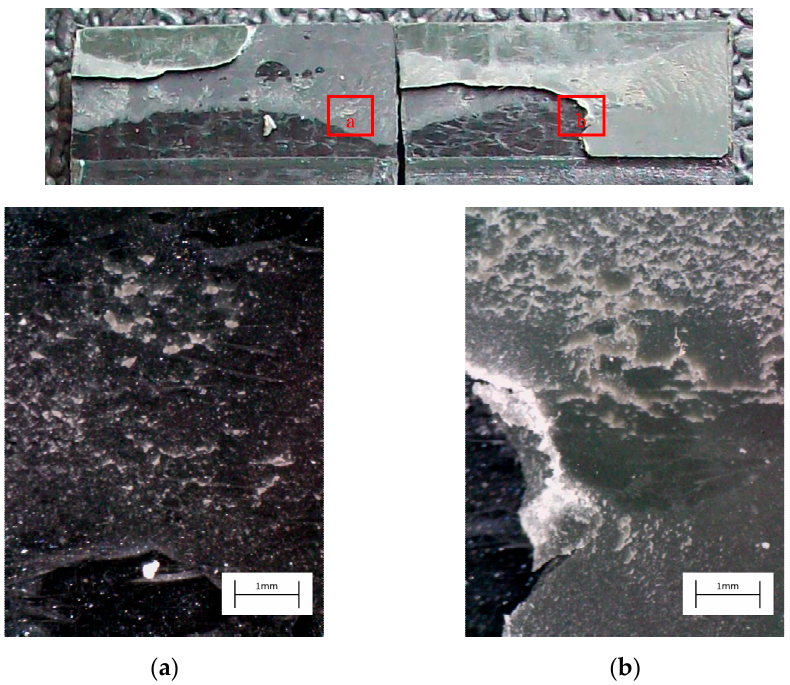
Figure 24. Fracture surface of a specimen pretreated with APPT with D = 5 mm and v = 200 mm/s and subjected to fatigue test, with magnified details ( a ) and ( b ) acquired by microscope.